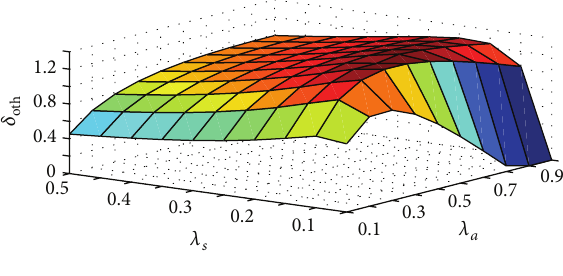
Figure 13: Effect of 𝜆 𝑠 and 𝜆 𝑎 on 𝛿